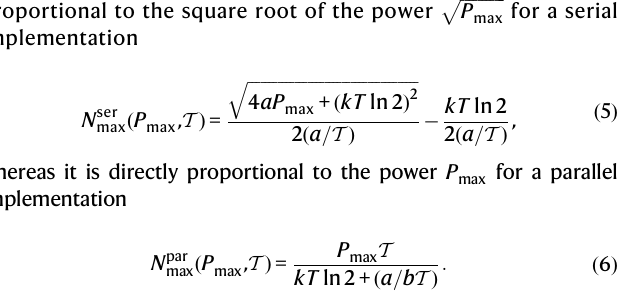
p ffiffiffiffiffiffiffiffiffiffiffi P max